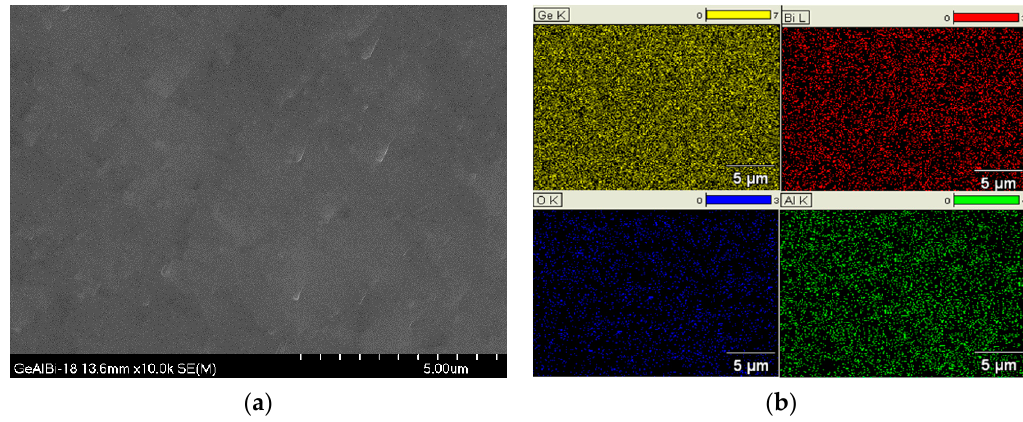
Figure 3. Example of ( a ) SEM micrograph fractured surfaces (magnification x10k) and ( b ) results of